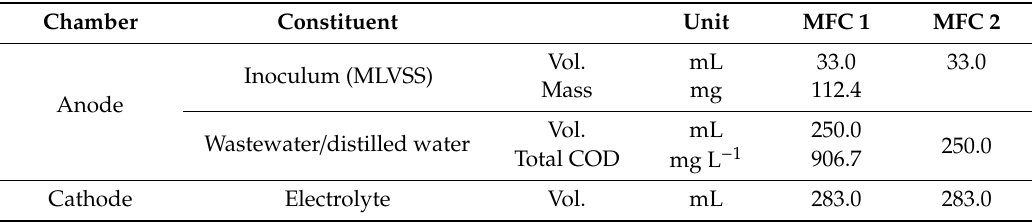
Table 1. Initial operating conditions of the microbial fuel cell (MFC).